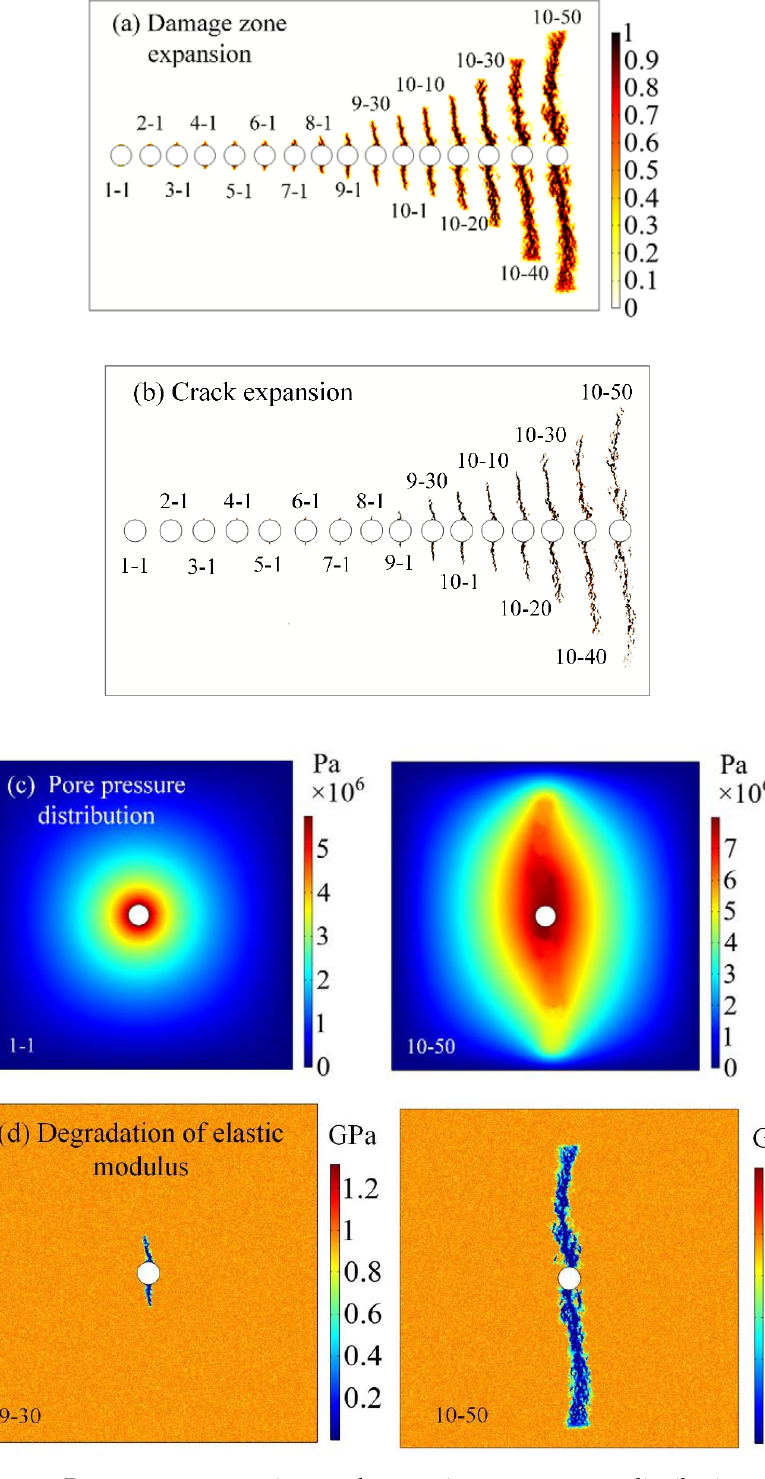
Figure 7. Damage zone expansion, crack expansion, pore pressure distribution and elastic modulus degradation law around hydraulic fracturing drilling when ξ = 0.5. (Note that: the color bar in Figure 7 ( a ) represents the damage variable, D ; the color bar in Figure 7 ( b ) represents the crack expansion, ( c ) represents the pore pressure value; the color bar in Figure 7 ( d ) represents the elastic modulus value at different areas).